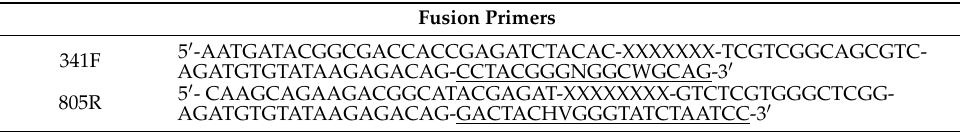
Table 1. Fusion primers used for bacterial